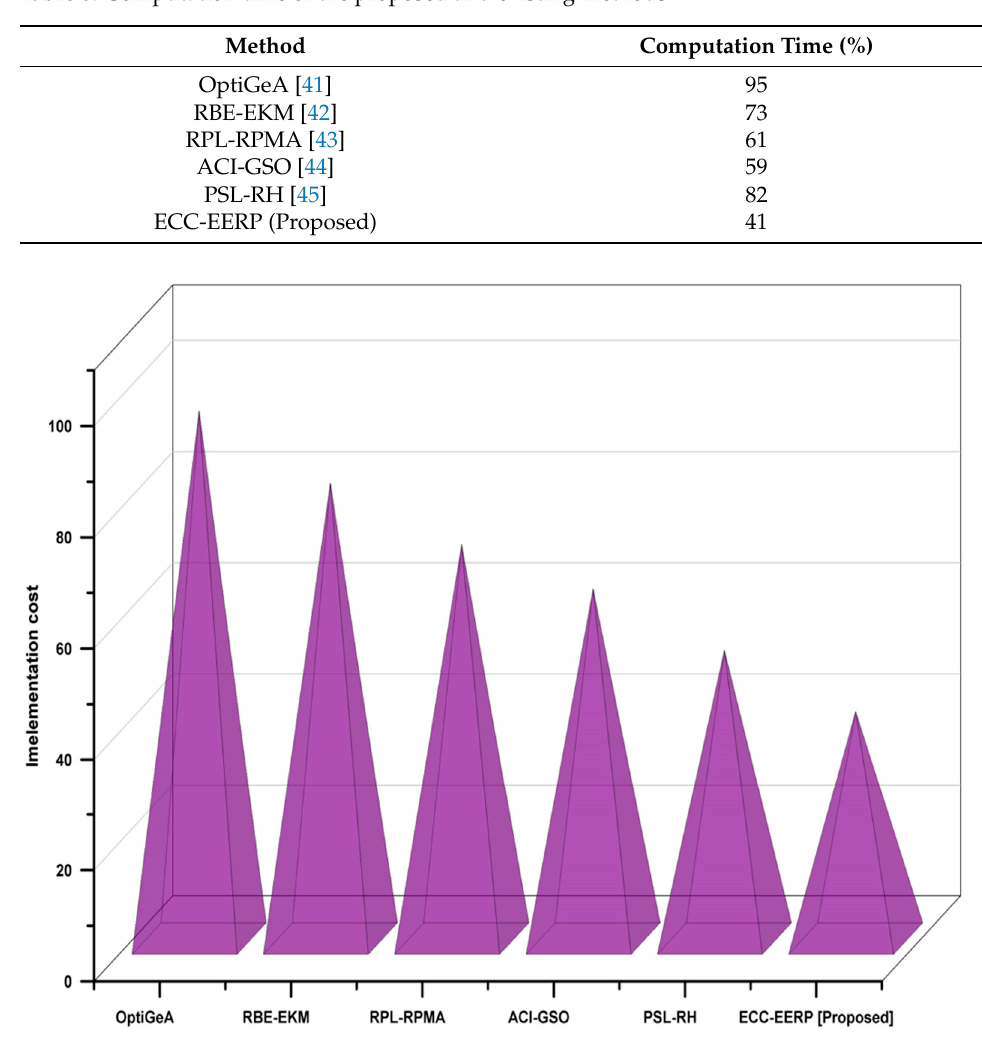
Table 8. Computation time of the proposed and existing methods.